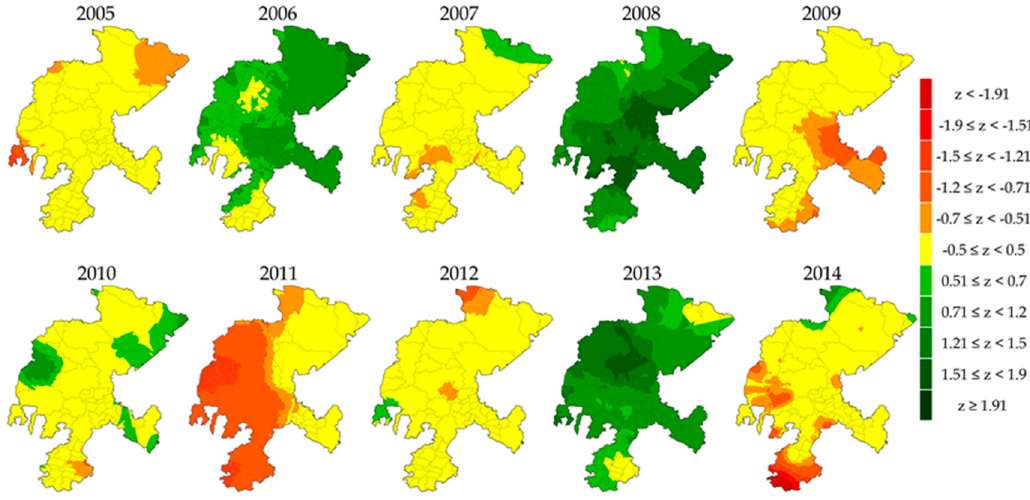
Figure A1. Three ‐ month timescale Standard Precipitation Index (July–September).